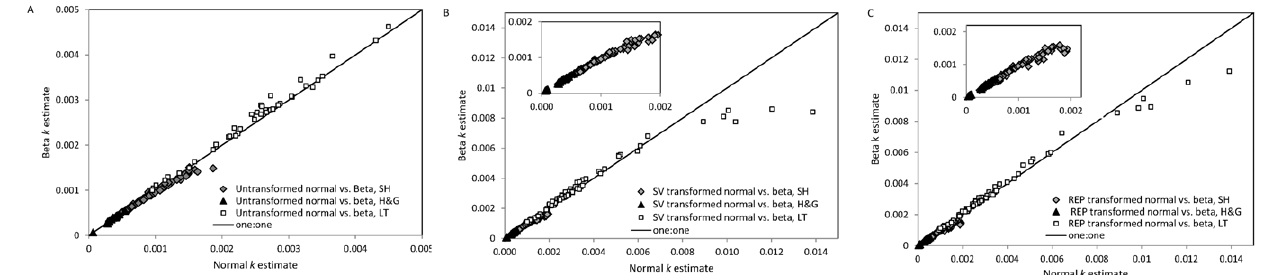
Figure 9. Daily decomposition rate ( k ) estimates for the Hobbie (SH) [ 14 ] , Laliberte´ and Tylianakis (LT) [ 12 ] and Hobbie and Gough (H&G) [ 10 ] data compared by error distribution (beta or normal) used to estimate k . (A) untransformed (B) Smithson and Verkuilen (SV) [ 6 ] transformed and (C) replacement (zeros=missing data; values $ 1=0.9999) transformed data sets. Insets in (b) and (c) show only the SH and H&G data.